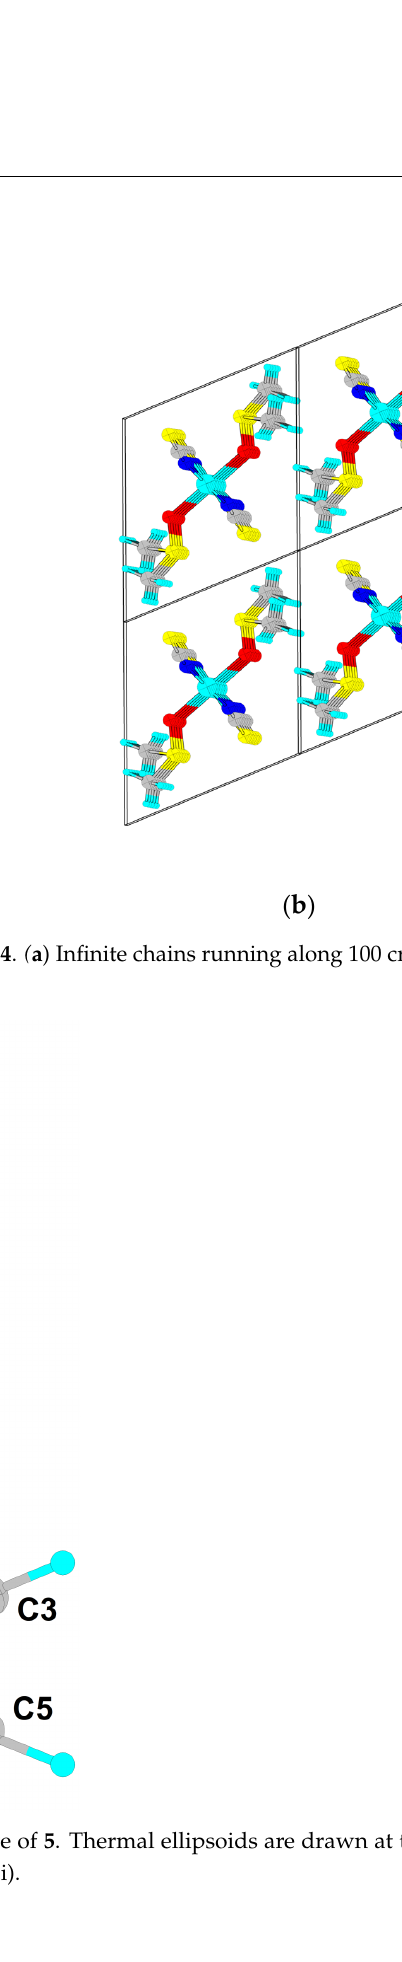
Figure 7. The molecular structure of 5 . Thermal ellipsoids are drawn at the 50% probability level. Symmetry operation: x, ½ − y, z (i).